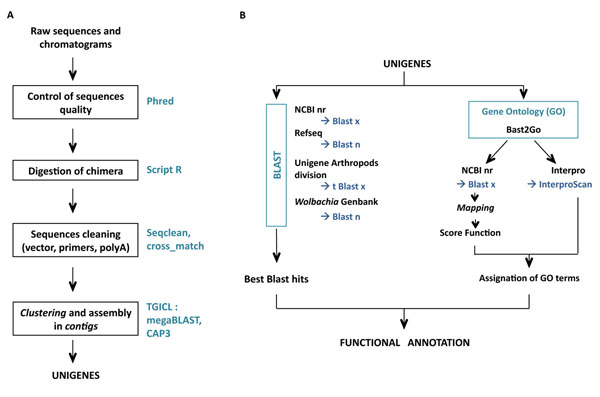
Sequence treatment (A) and functional annotation procedure (B).